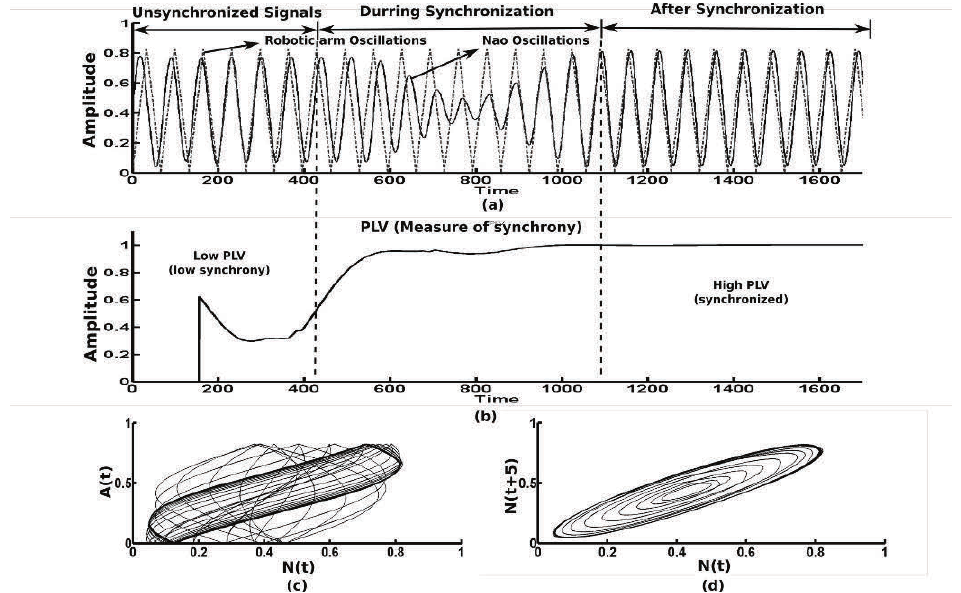
Figure 4. Nao-automaton interaction: (a) Motion signals the automaton and the Nao’s modifiable oscillator (b) PLV measurement ( 1 for complete synchronization and 0 for completely asynchrony) (c) Lissajous curve between N ( t ) (Nao’s oscillation) and A ( t ) (automaton’s movements). (d) Lissajous curve between two di(cid:636)erent time values of Nao ( N ( t ) and N ( t + 5)